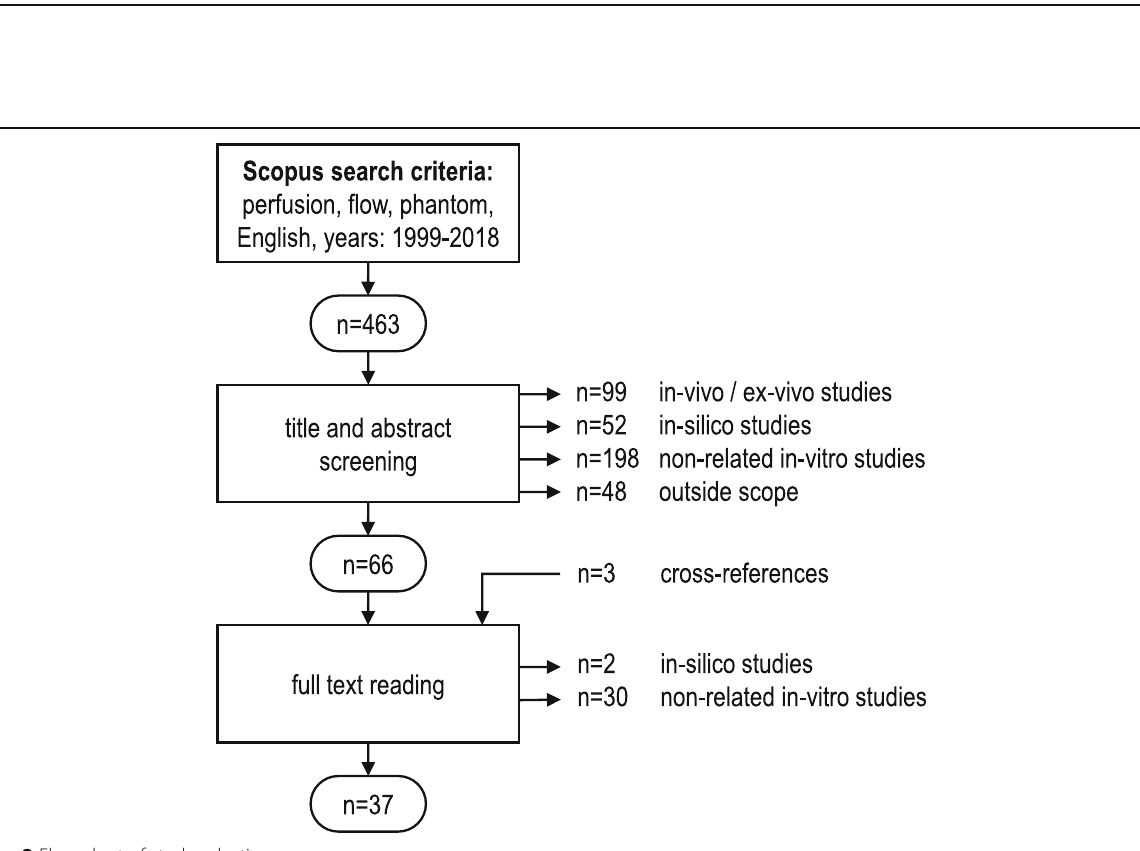
Fig. 2 Flow chart of study selection